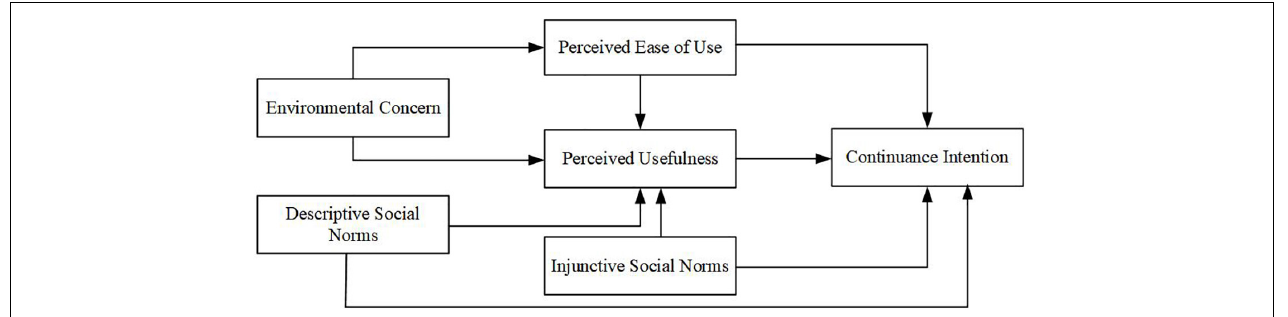
FIGURE 1 | Conceptual